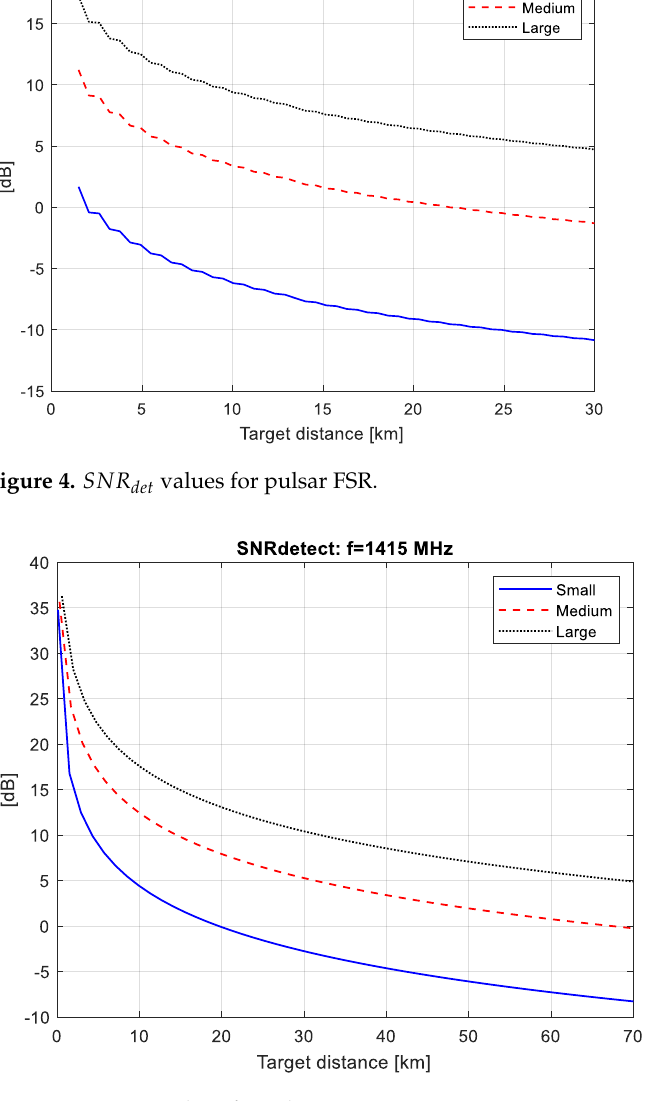
Figure 5. 𝑆𝑁𝑅 𝑑𝑒𝑡 values for solar FSR. Figure 5. SNR det values for solar